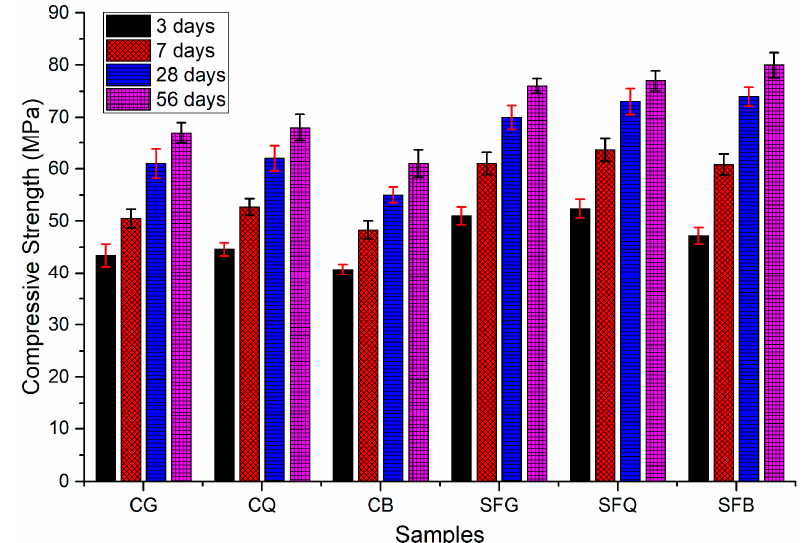
Figure 3. Compressive strength test results (the specimens made with only cement as binder were noted with the acronyms CG, CQ and CB for concrete with granite, with quartz and with basalt aggregates, respectively). Those containing silica fume were called SFG, SFQ and SFB, accordingly